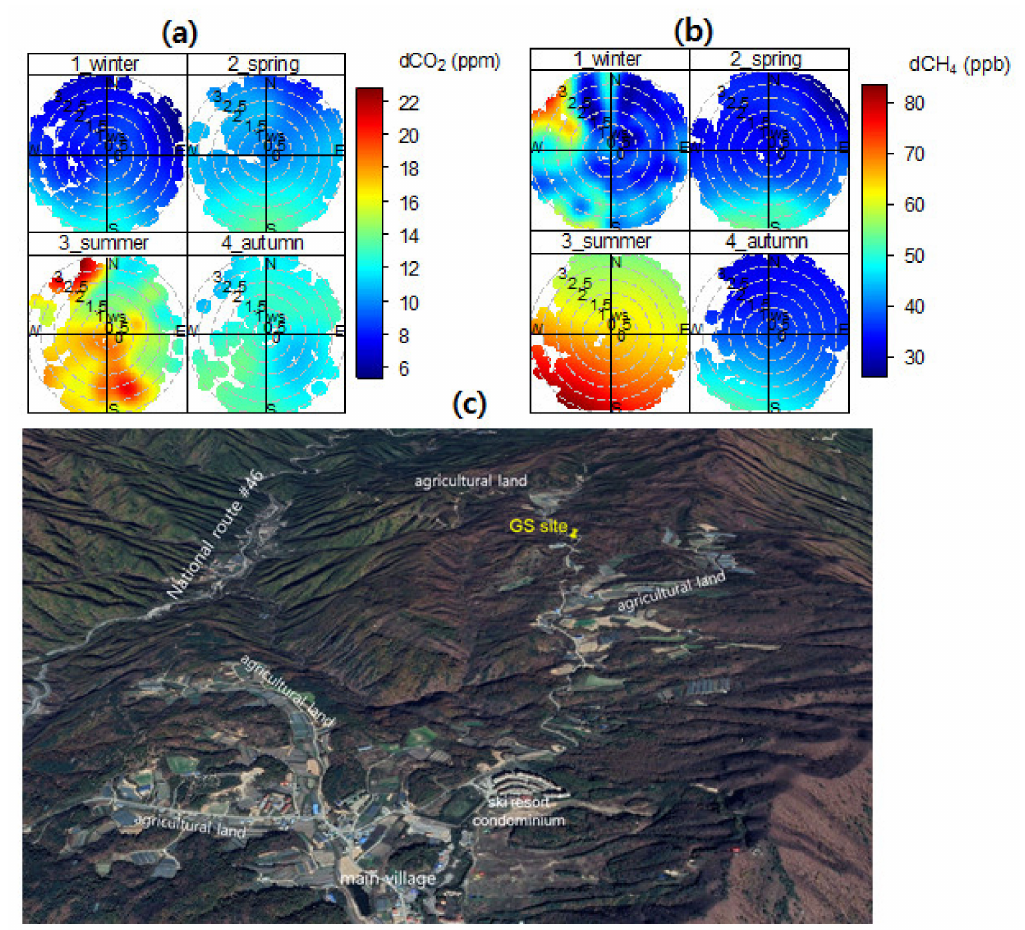
Figure 6. Bivariate polar plots for ( a ) dCO 2 and ( b ) dCH 4 together with ( c ) map showing the locations of the GS site and surrounded emission